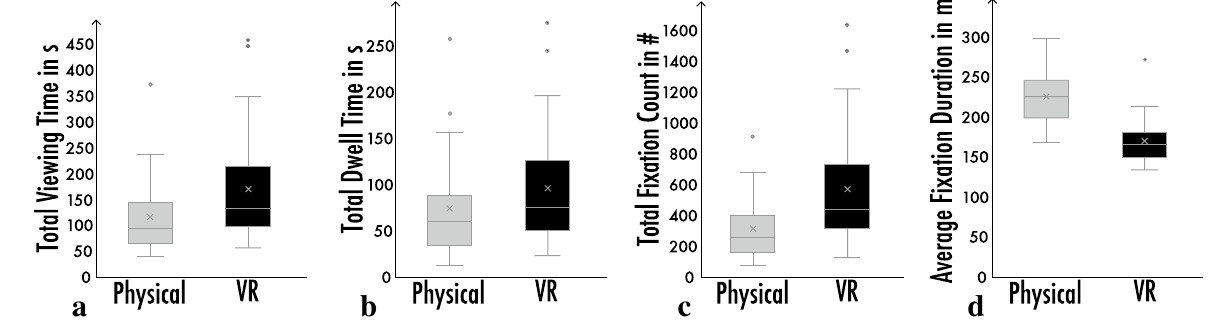
Figure 4. Main descriptive statistics comparing physical and VR environments: ( a ) total viewing time in seconds, ( b ) total dwell time in seconds, ( c ) total fixation count, and ( d ) average fixation duration in milliseconds illustrated as box-plots. Each box was drawn from first quartile (Q1) to third quartile (Q3) with a horizontal line denoting the median, and a cross denoting mean. Whiskers indicate minimum and maximum except outliers. Outliers were visualised as points ± 1.5 interquartile range. On average, participants spent about two minutes in physical installation and three minutes in virtual installation. Since viewing duration correlates